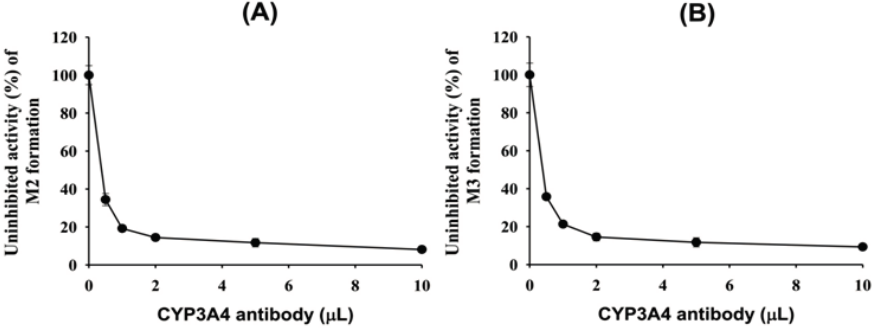
Figure 5. Effect of an anti-CYP3A4 antibody on the metabolism of evogliptin (50 μ M) to ( A ) 4( S )- hydroxyevogliptin (M2) and ( B ) 4( R )-hydroxyevogliptin (M3) in pooled human liver microsomes. 2.3. Characterization of Human UGT Enzymes Responsible for the Formation of 4-Hydroxyevogliptin Glucuronide (M4) from 4(S)-Hydroxyevogliptin